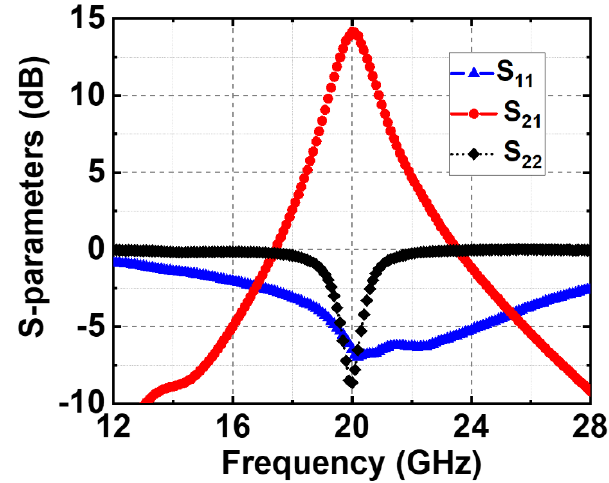
Figure 4. Measured S-parameters of the TSV integrated f T -doubler radio-frequency amplifier